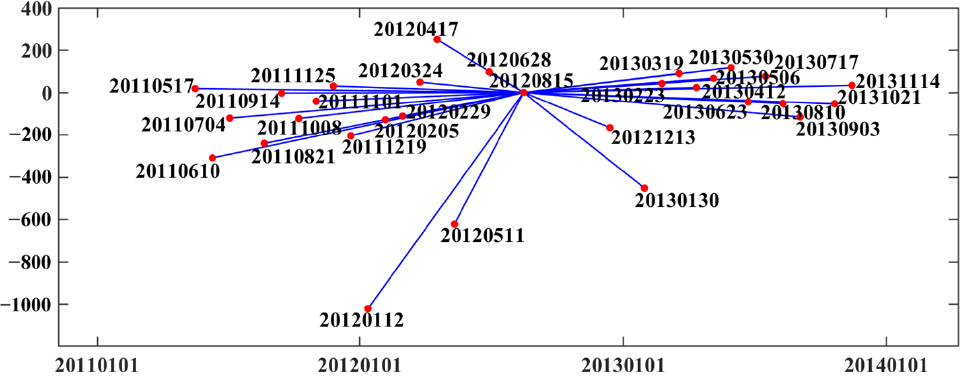
Figure 7. Perpendicular and temporal baselines of single-master pairs (master image: 20120815) of real datasets.